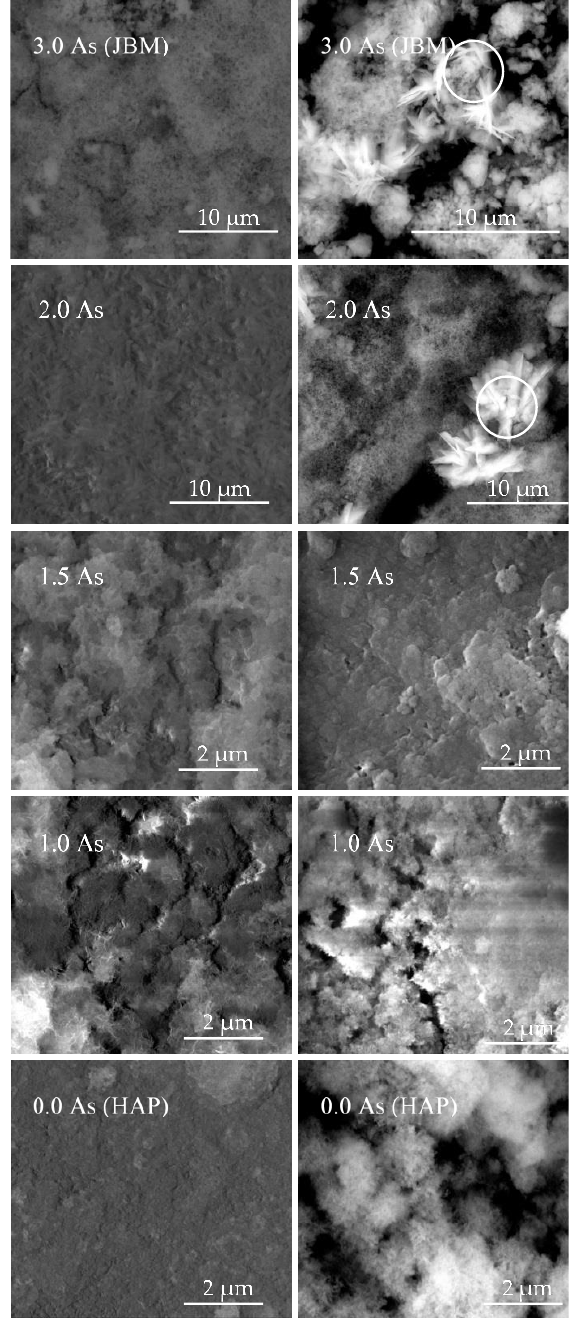
Figure 1. Scanning electron micrographs of synthetic Ca 5 (AsO 4 ) m (PO 4 ) 3− m OH solid solutions ( left ) before and ( right ) after the dissolution experiment. Secondary phases possibly resulting from incongruent dissolution are marked with circles. Table 2. Elemental composition of the synthesized phases.